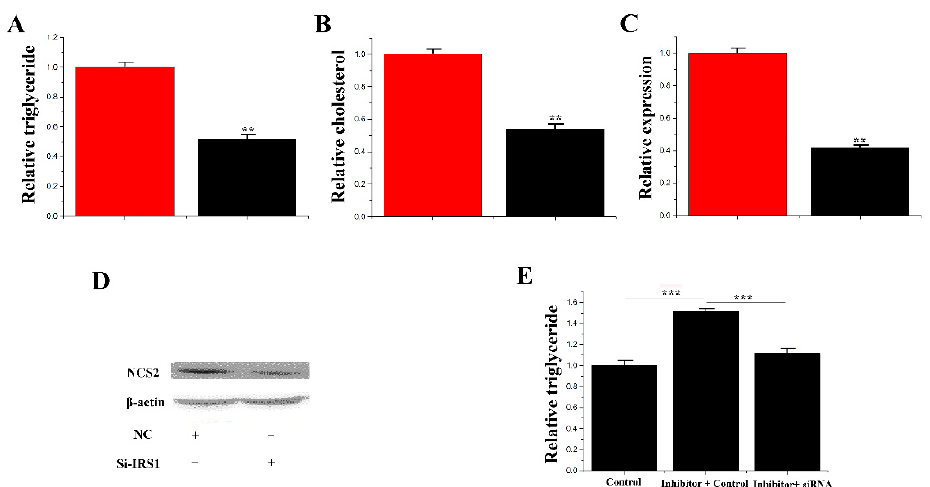
Figure 9. Functional evaluation of IRS1 . ( A ) TAG levels in cells transfected with Si-NC or SiRNA- IRS1; TAG levels in transfected cells were compared with Si-NC ( n = 6). Red bars represent the negative control; black bars represent SiRNA- IRS1; ( B ) Cholesterol levels in transfected cells were compared with controls ( n = 6). Red bars represent the negative control; black bars represent the siRNA- IRS1; ( C ) The expression of β -casein was quantified by RT-qPCR ( n = 6); ( D ) The effect of si-NC (60 nM) or siRNA- IRS1 (60 nM) on β -casein protein expression was evaluated by Western blot in CMECs; ( E ) TAG levels in cells transfected with control inhibitor (50 nM) + control siRNA (50 nM), inhibitor 183 (50 nM) + control siRNA (50 nM) and inhibitor 183 (50 nM) + siRNA- IRS1 (50 nM); TAG levels were compared with that of controls ( n = 6). Values are presented as means ± deviation, ** p < 0.01; *** p < 0.001.